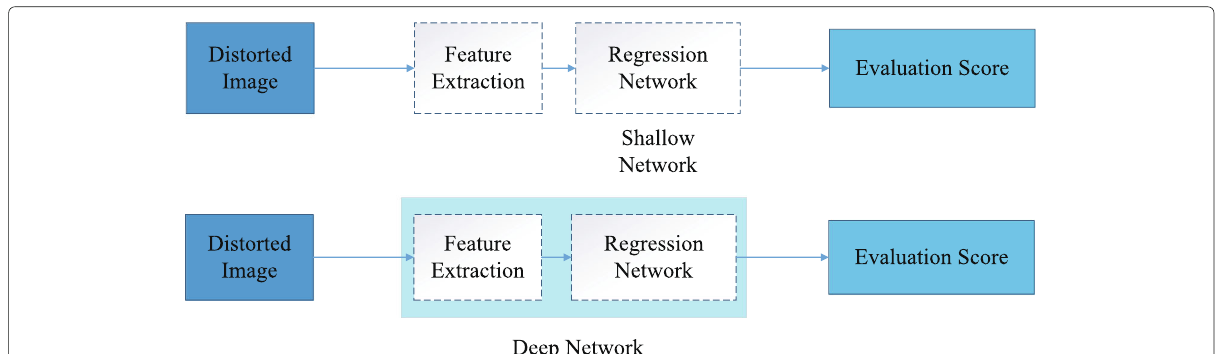
Fig. 1 Comparison of explicit and implicit network